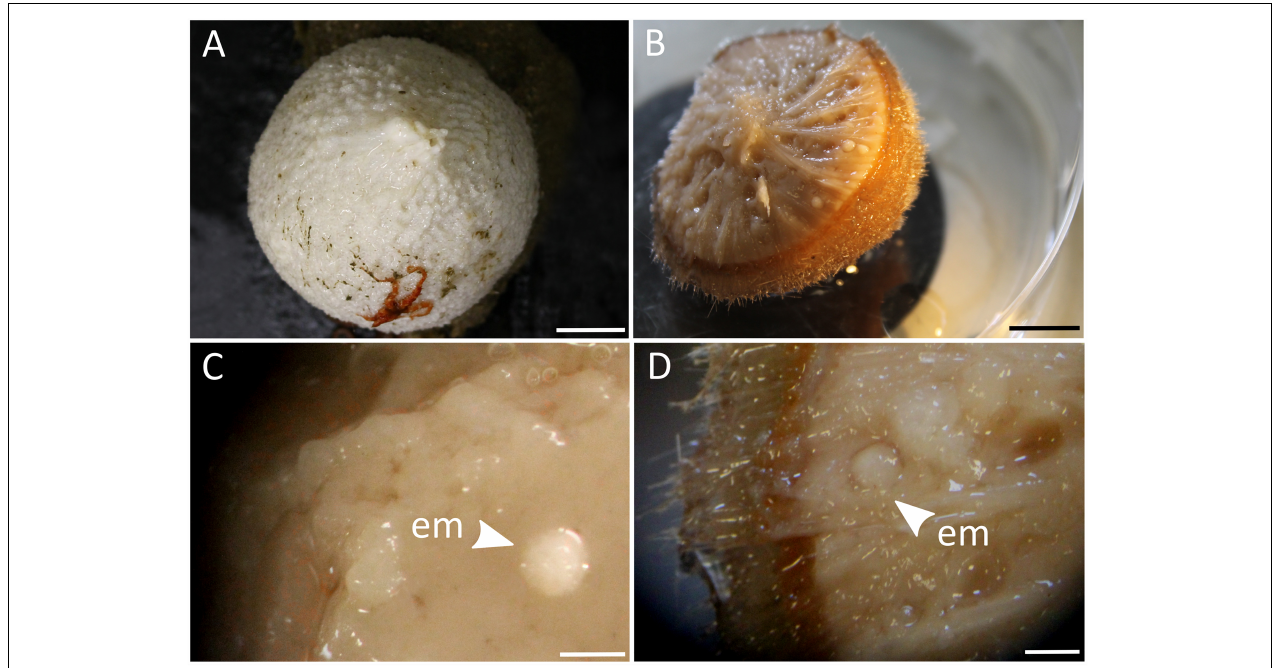
FIGURE 2 | (A) Photograph of an adult C . zetlandica individual with an attached red brittle star at the bottom. Scale bar = 1 cm. (B) Photograph of an adult C . infrequens individual that was cut in half, showing numerous embryos inside the sponge tissue. Scale bar 1 cm. (C) Stereomicroscopic magnification of C . zetlandica tissue. em, embryo. Scale bar = 1 mm. (D) Stereomicroscopic magnification of C . infrequens tissue. em, embryo(s) brooding in the mesohyl. Scale bar = 1